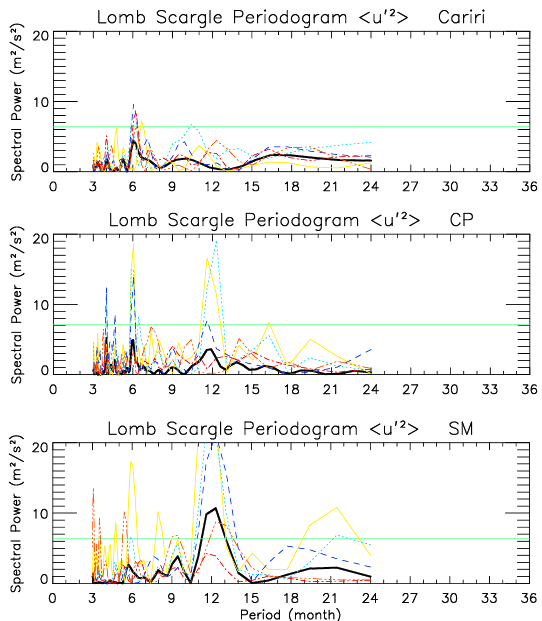
Figure 9. Lomb–Scargle spectral analysis of zonal component of GW variance over São João do Cariri (top), Cachoeira Paulista (middle), and Santa Maria (bottom). The horizontal straight green lines show the 90% confidence levels. For all stations the solid black line represents the height-averaged profile, the solid yellow line 82km, the cyan dotted line 85.5km, the blue dashed line 89km, red dash-dot line 92.5km, and the orange dash-dot line